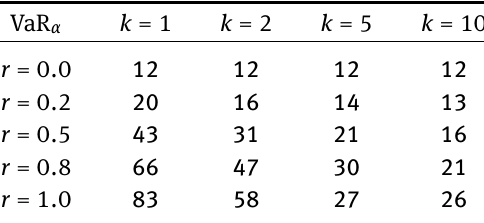
Table 4.4: Simulation of VaR α ( S ) for d = 50 , α = 0.95 ; fully specified factor model